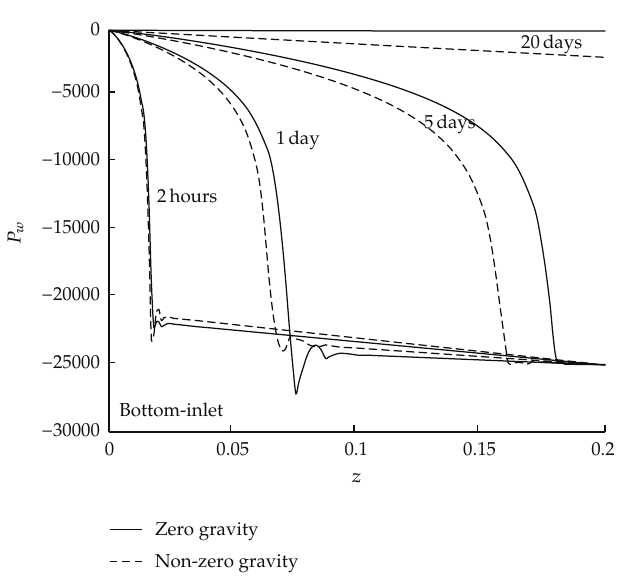
Figure 16: Comparison between considering and neglecting gravity e ff ect on water pressure for the bottom-inlet case, at x (cid:8) 0 . 1m.